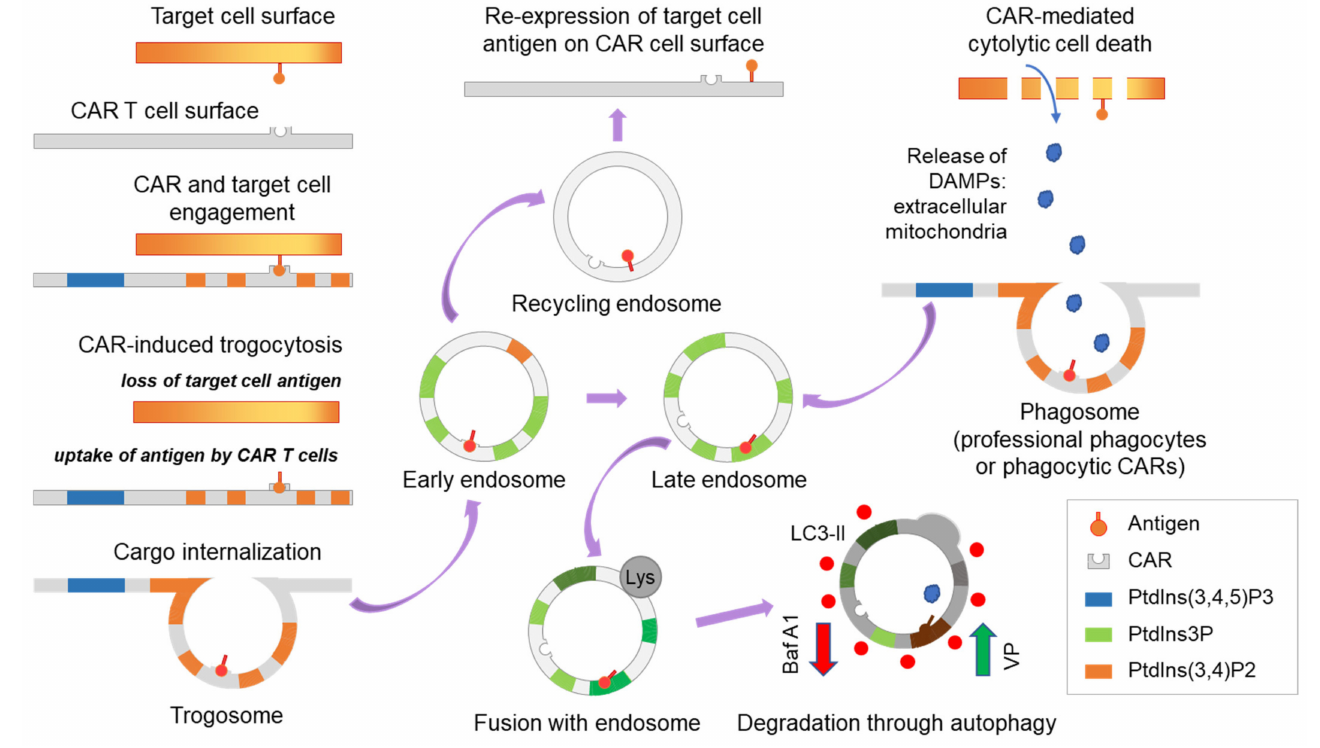
Figure 4. Scheme demonstrating CAR-induced trogocytosis. Trogocytosis occurs upon CAR-target engagement resulting in the expression of the target tumor antigen on CAR T cells. Following extraction by CAR T cells, the tumor antigen is internalized and processed through the endosome system and then is either recycled to the cell surface or shuttled to late endosomes and subsequently degraded through lysosome and autophagy-dependent mechanisms. Activation and inhibition of autophagy may regulate trogocytosis and modulate CAR T cell function. In addition, trogocytosis may interface with phagocytosis. Baf A1, bafilomycin A1, an inhibitor of vacuolar ATPase and autophagy; VP, verteporfin, an activator of selective autophagy; DAMPs, damage-associated molecular